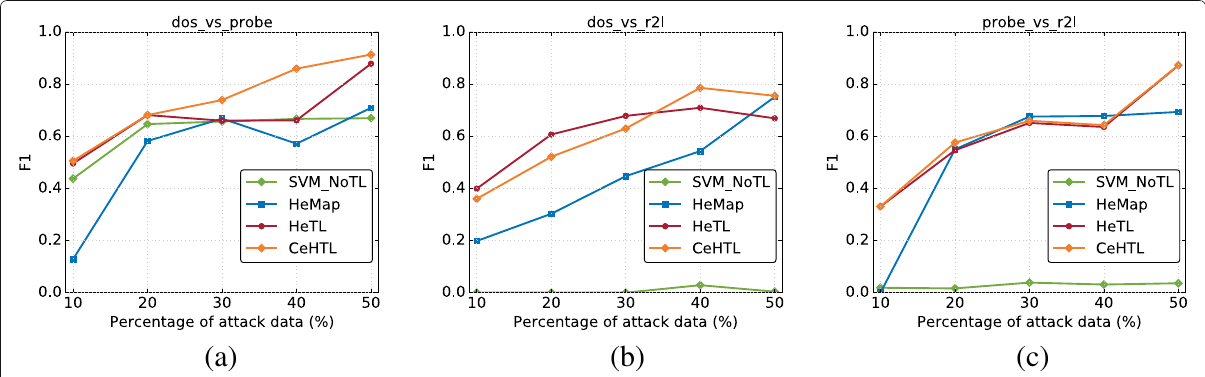
Fig. 12 The performance on imbalanced data by varying the portion of attack data, sample = 1000. a DoS → Probe. b DoS → R2L. c Probe → R2L